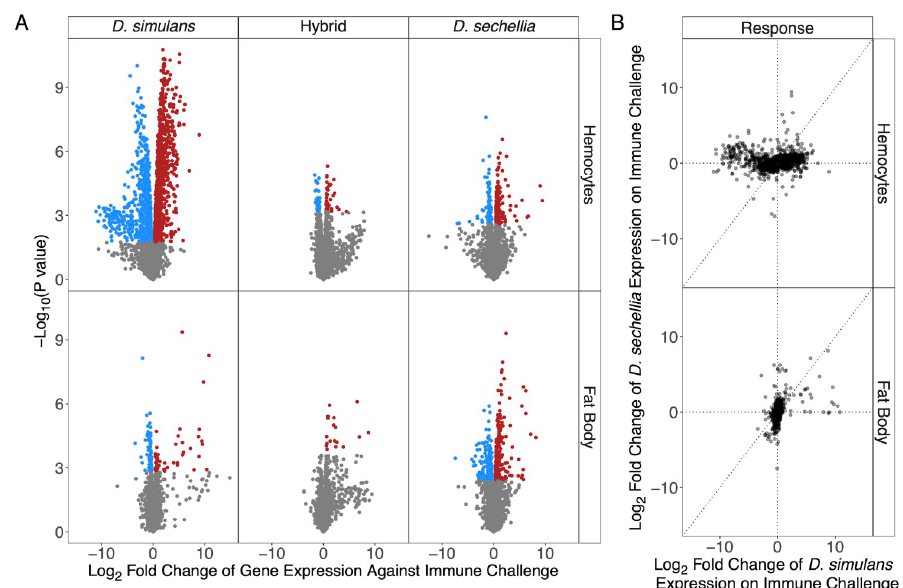
Fig 2. Divergence of the transcriptional response to immune challenge in fat body and hemocytes. Larvae were immune challenged by injecting them with mineral oil containing wasp homogenate while control larvae were not injected. The transcriptional response was then measured by RNA sequencing 24 hours post injection. (A) Volcano plots comparing the magnitude and statistical significance of changes in gene expression after immune challenge. Each point is a gene, and they are coloured above an FDR threshold of 5%. (B) The magnitude of the transcriptional response to immune challenge in D. simulans compared to D. sechellia . Each point is a